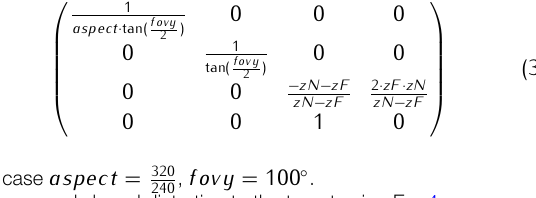
2. blinking red — the desired position is not reachable 3 ; 3. rotating blue — the robot is moving. There are two buttons in the local video area to allow the user to per- form a 180 ◦ rotation (clockwise and counter-clockwise). Additionally, a speedometer is placed on the right side of the video stream.